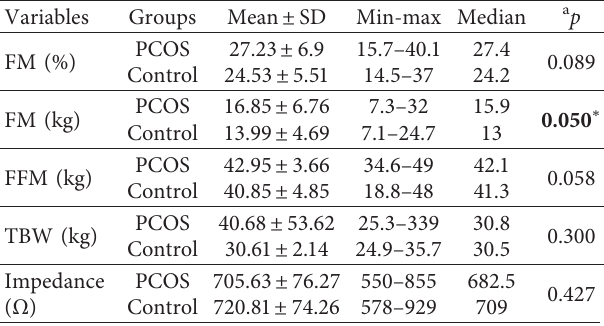
Table 2: Total body composition